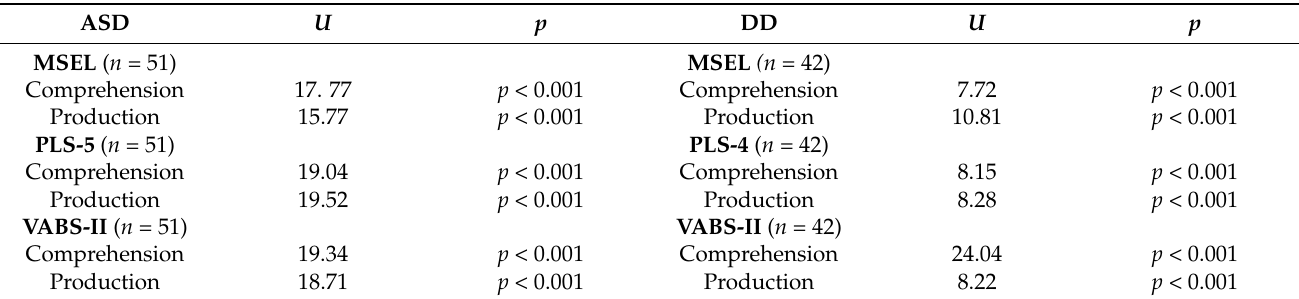
Table 2. Differences for equivalent ages for MSEL, PLS, and VABS-II in language comprehension and production compared to chronological age.